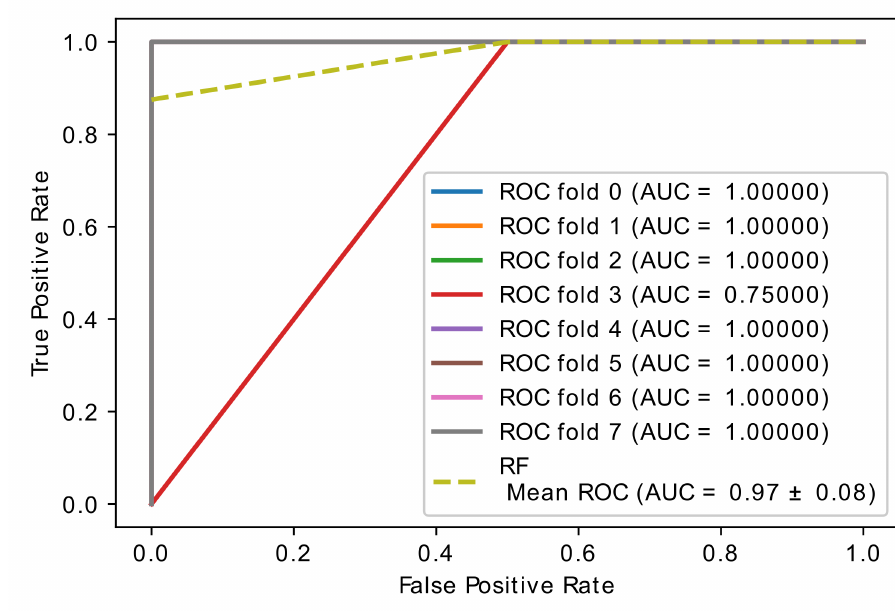
Figure 8. Accuracy curve of random forest classifier.